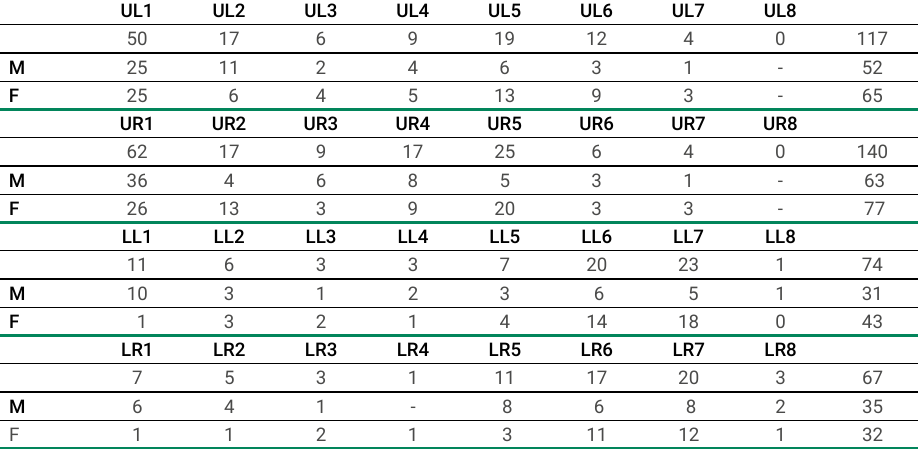
Table 2. Distribution of crowned teeth according to